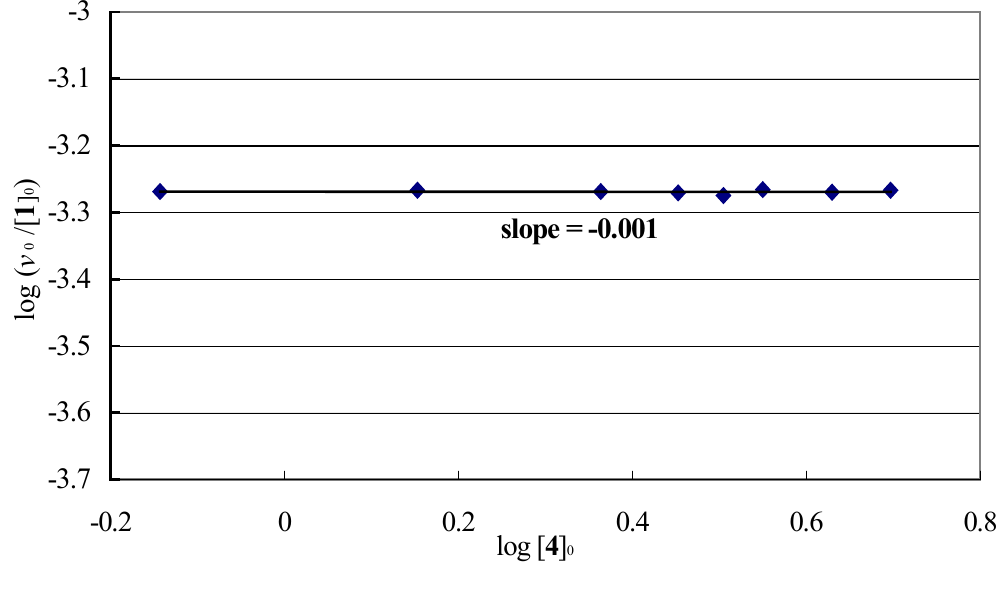
Figure 2 . The logarithms of υ /[ 1 ] are plotted against the logarithms of [ 4 ] 0 0 the reaction of sulfenamide 1 (4.0 mmol) with thioanisole 4 in the presence of both TFA (8.0 mL) and CH Cl at 10 ° C: A mixture (16 mL) of 4 and CH 2 2 used, and υ , [ 1 ] and [ 4 ] mean the initial rate for the production of 2- and 0 0 0 4-(methylthio)phenyl phenyl sulfides 5 , the initial concentration of 1 and the initial concentration of 4 ,